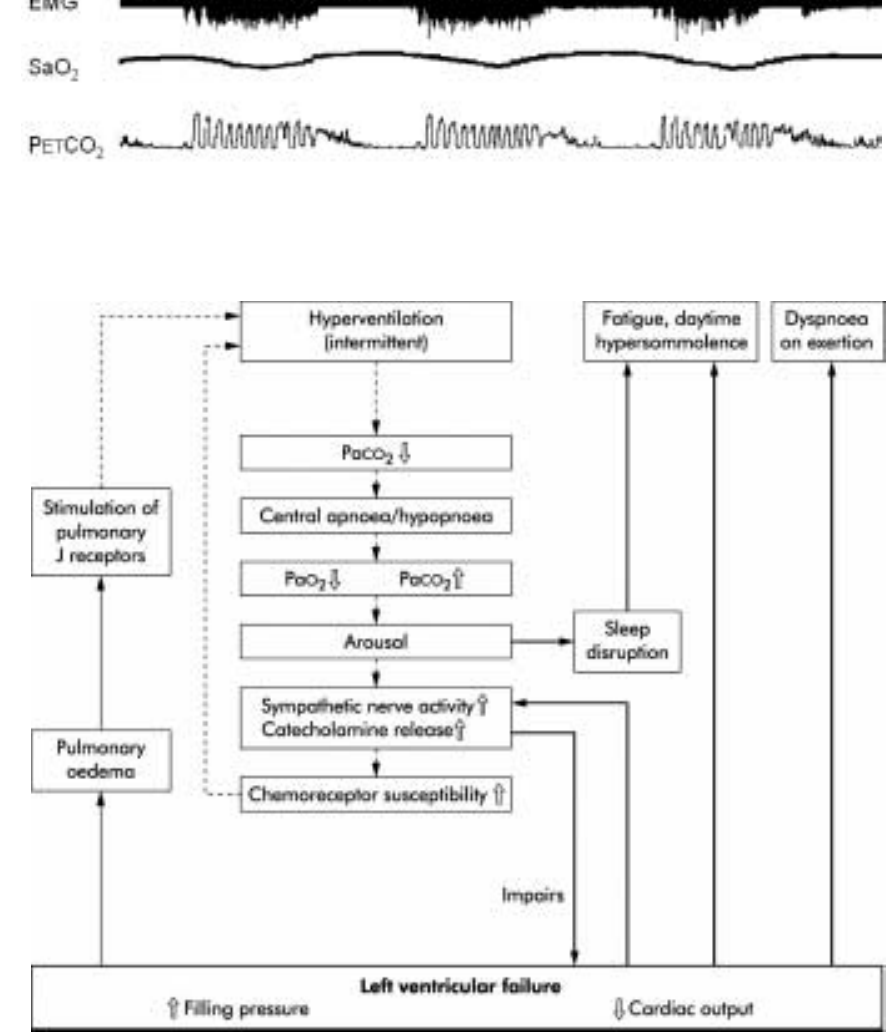
Tracing during 90 sec of Cheyne-Stokes respi- ration in a patient with congestive heart failure. The top panel shows the instantaneous lung volume (Sum) measured with an inductance plethysmograph. The needle electro-myogra- phy (EMG) of the scalene muscle depicts the tonic and phasic activity during the hyper- pnoea in opposite to the atony during the ap- noea. Oxygen saturation (SaO 2 ) monitored by pulse oximetry at the ear lobe oscillates be- tween 85% and 95% during apnoea and hyper- pnoea, respectively. End-tidal CO 2 (P ET CO 2 ) peaks at 38 mm Hg at the beginning of hyper- pnoea and continually decreases to 28 mm Hg before apnoea occurs.